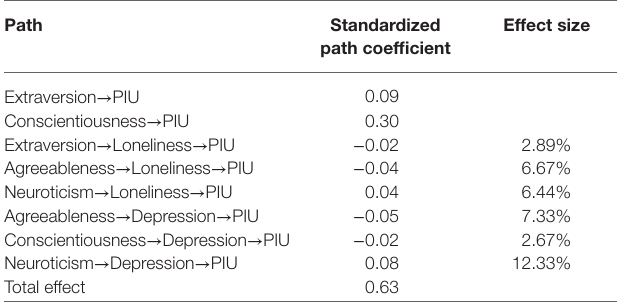
TABLE 4 | The influence path of the five personalities on